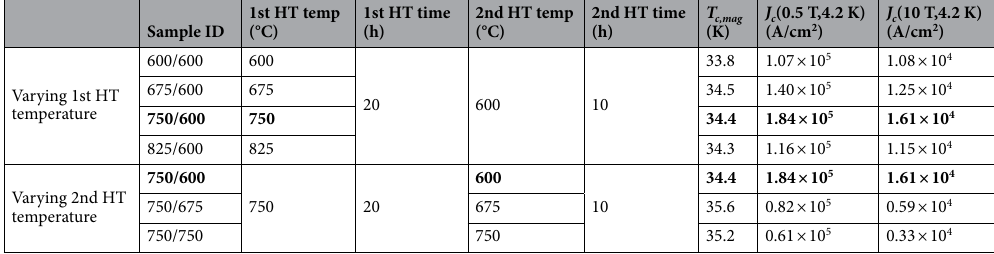
Table 1. Sample heat treatment schedules, magnetic onsets and critical current densities at 4.2 K at both 0.5 and 10 T. In the two series the same sample is marked with bold fonts.